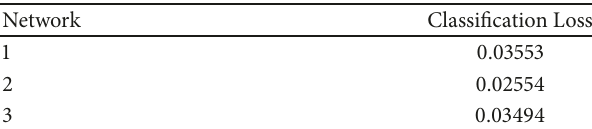
Table 1: Object distribution for imbalanced networks. Table 2: Classification Loss for Networks 1, 2, and